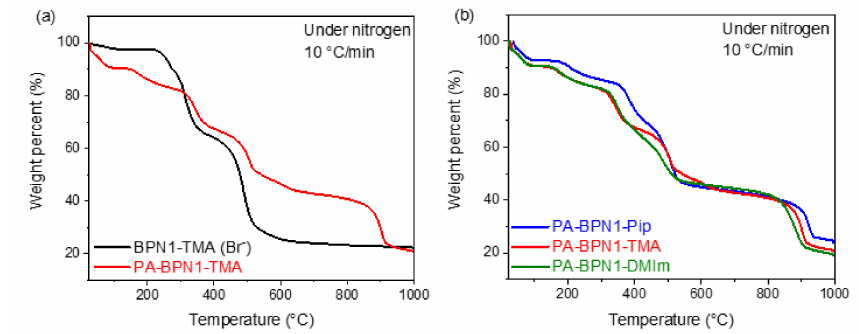
Figure 3. Thermogravimetric analysis (TGA) curves of ( a ) BPN1-TMA(Br − ) and PA-BPN1-TMA; and ( b ) PA-BPN1-TMA, PA-BPN1-Pip and